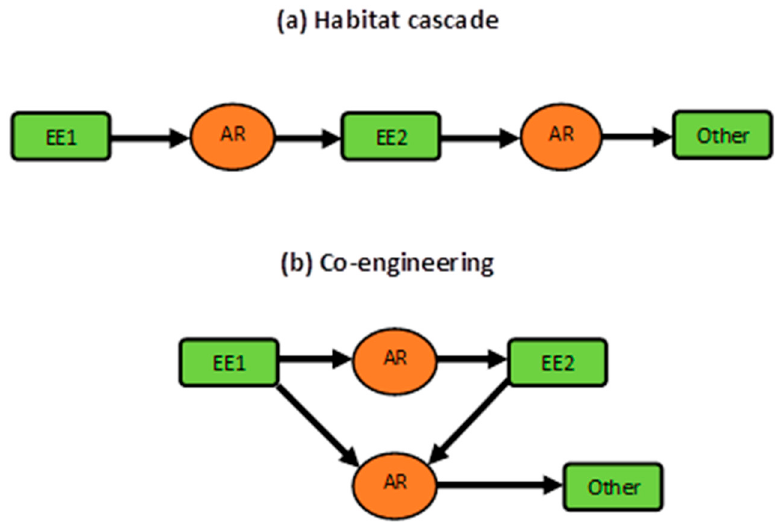
Figure 1. Compound ecosystem engineering impacts on other organisms: ( a ) A habitat cascade where a primary engineer (EE1) alters abiotic conditions or resources (AR), thus facilitating a secondary engineer (EE2) that in turn creates abiotic conditions or resource levels (AR) favorable to other organisms (Other); ( b ) Co-engineering where a primary engineer (EE1) facilitates a secondary engineer (EE2) via changes in abiotic conditions and resources (AR), and they both have concurrent, joint impacts on abiotic conditions and resources (AR) that affect other organisms (Other).